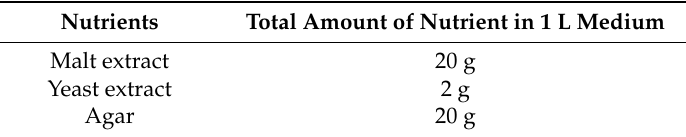
Table A6. Malt Yeast-extract (MY, Lilly and Barnett,